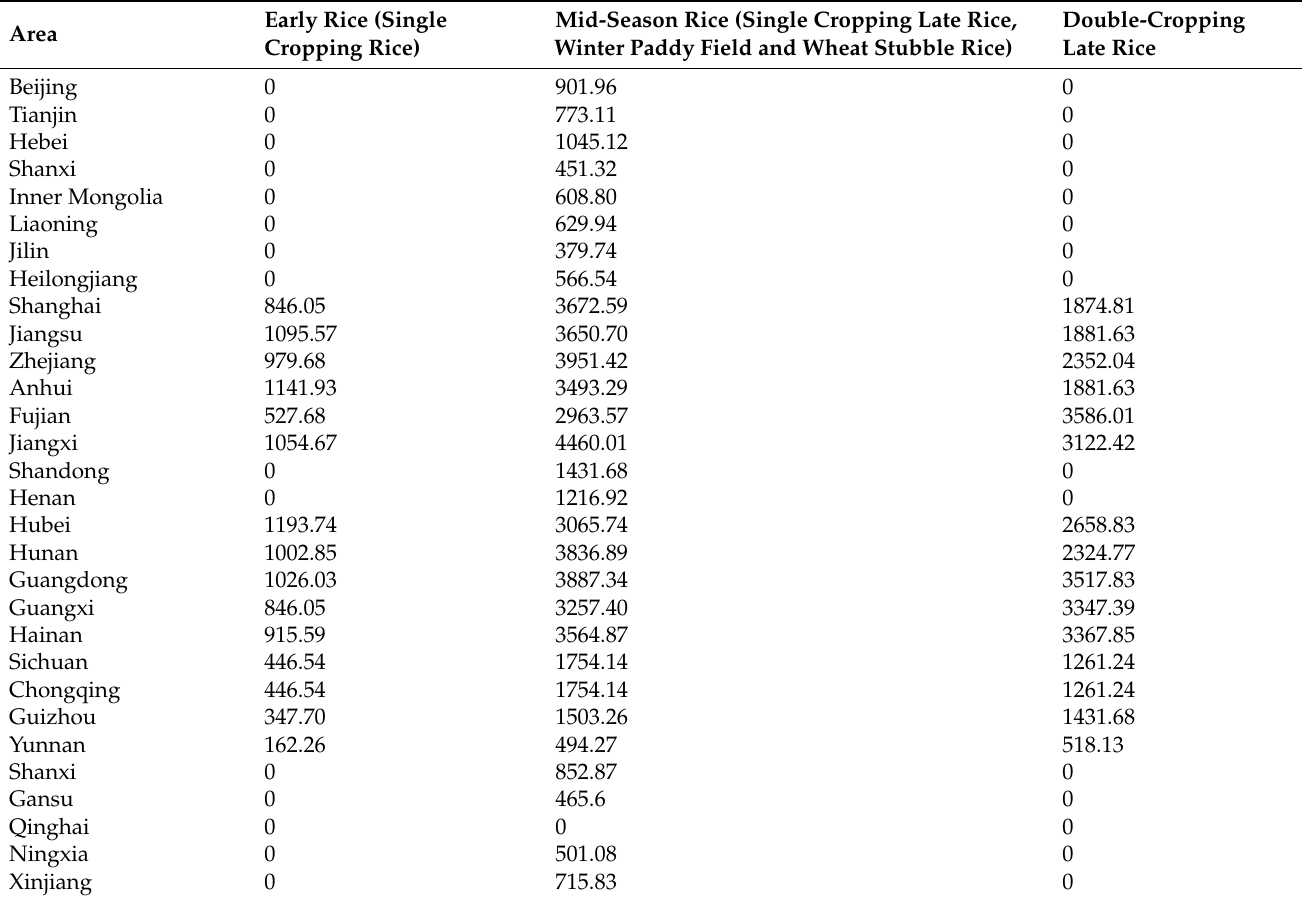
Table A2. Rice carbon emission coefficients in each province. Unit: kg · hm − 1